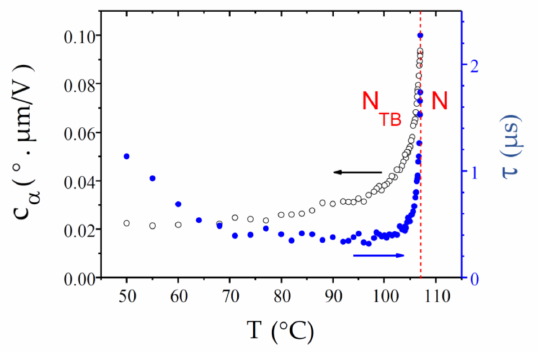
Figure 9. Temperature dependence of the ECE parameters, c α ( T ) and τ ( T ) , measured in the N TB phase of the bent-shaped dimer CB9CB. For this compound, the N-N TB biphasic coexistence tempera- ture range is very narrow and almost